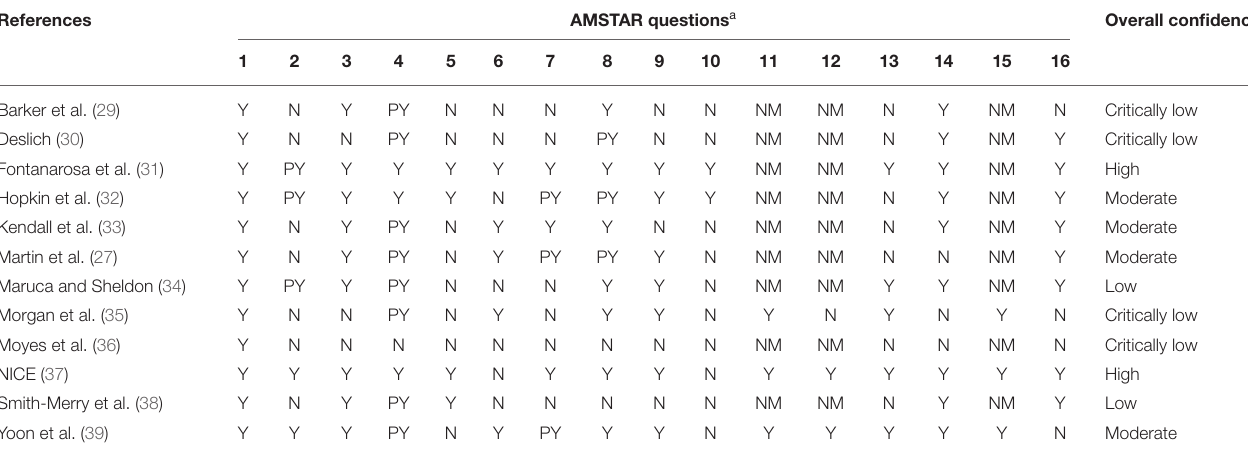
TABLE 2 | AMSTAR-2 ratings for included systematic reviews and